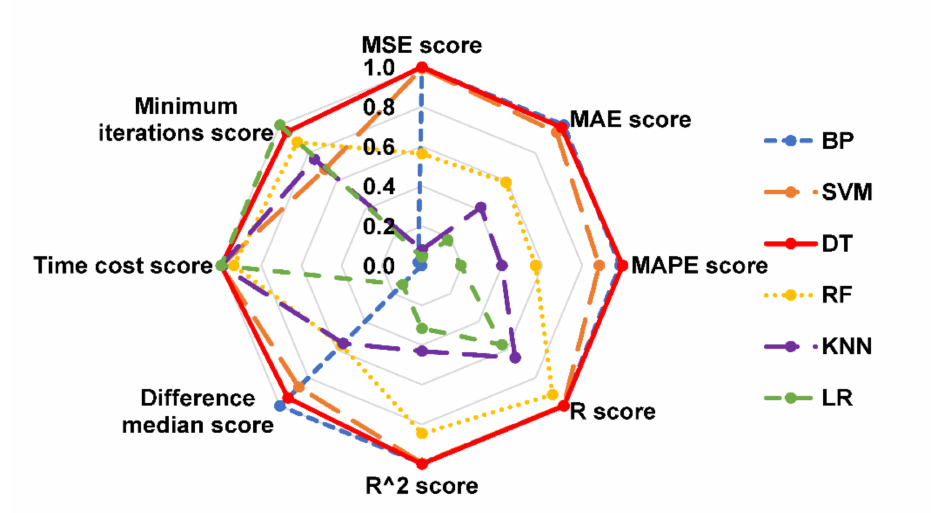
Figure 10. Radar plot of di ff erent ML algorithms to compare di ff erent statistical